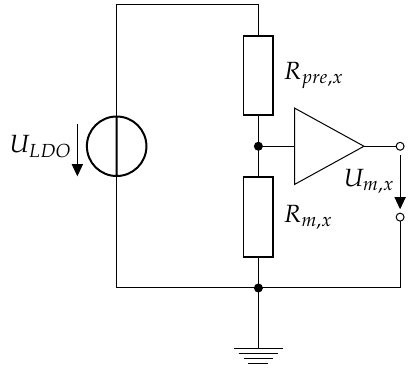
Figure 6. Electrical circuit used for sensor resistance